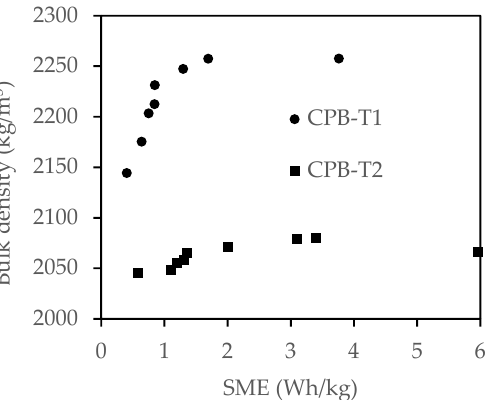
Figure 9. Effect of the SME on the bulk density of cylindrical probes used to determine the UCS of CPB-T1 and CPB-T2 at a curing time of 7 days.